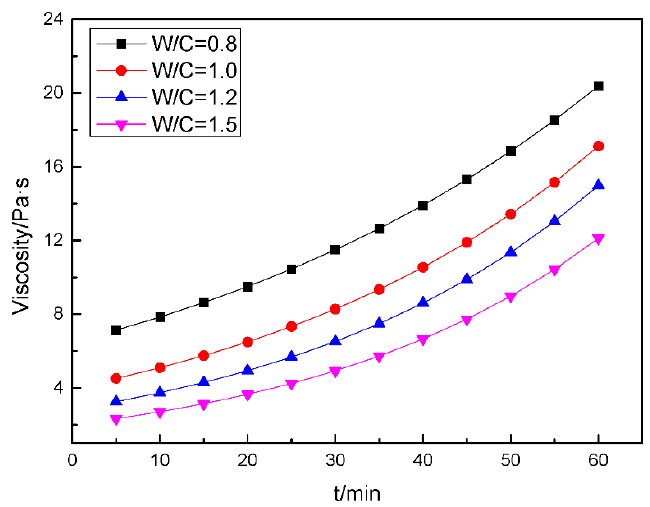
Figure 10. Variation of viscosity of cement slurry with different proportions.